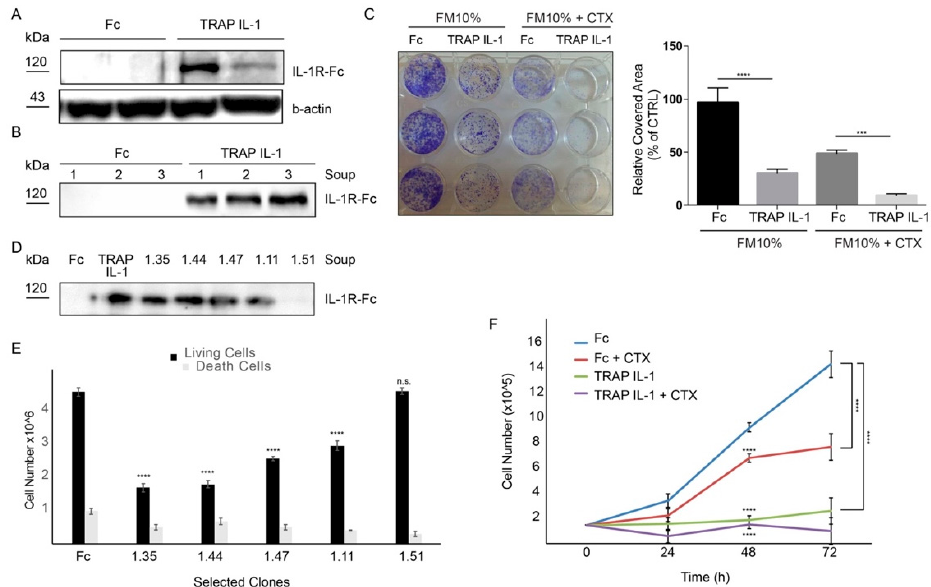
Figure 2. A recombinant decoy containing IL-1R1 inhibits Caco-2 growth. ( A ) Western blot analysis of Caco-2 TRAP IL-1 and Fc. Actin served as loading control. 500,000 cells were plated in medium with 10% FBS, then cells were serum starved overnight. The day after cells were harvested and total proteins extracted for TRAP IL-1 detection. ( B ) Western blot analysis of three replicates of Caco-2 Fc and Caco-2 TRAP IL-1 soup. 500,000 cells were plated in DMEM supplemented with 10% FBS and after 5 days the soup was harvested and 20 μ L used for the analysis. ( C ) Colony-forming assay of Caco-2 Fc and Caco-2 TRAP IL-1. 4000 cells/well were plated and grown in the absence or presence of CTX (5 μ g/mL) for 10 days in medium containing 10% of serum. Cells were then fixed, stained with crystal violet and photographed. Representative figures (left) and quantification (right) of the covered areas by ImageJ are provided. The statistic was calculated by 2-way ANOVA, *** p < 0.0005. These experiments were repeated at least three times. ( D ) Western blot analysis of Caco-2 TRAP IL-1 clones soup. 1.35–1.44–1.47–1.11 and 1.51 are clones derived from a single cell. Each clone soup was collected 5 days after seeding. TRAP IL-1 (purified protein) and Fc are intended as positive and negative controls respectively. ( E ) Clones from D were seeded and both living and death cells were